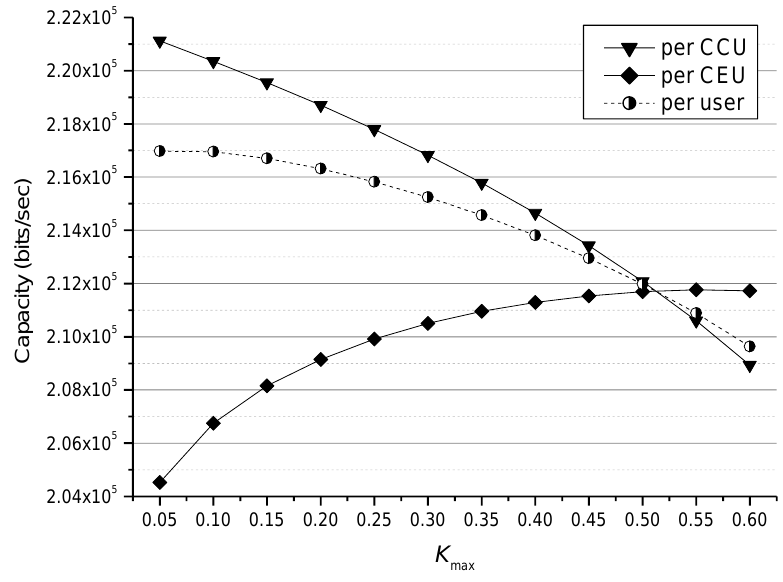
Figure 2. Capacity comparison for SU-network MIMO in terms of different values of 𝐾 max .